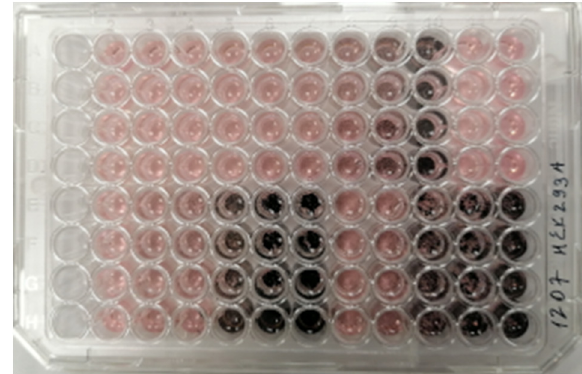
Figure 4. A 96-well cell culture plate with NDC samples added.